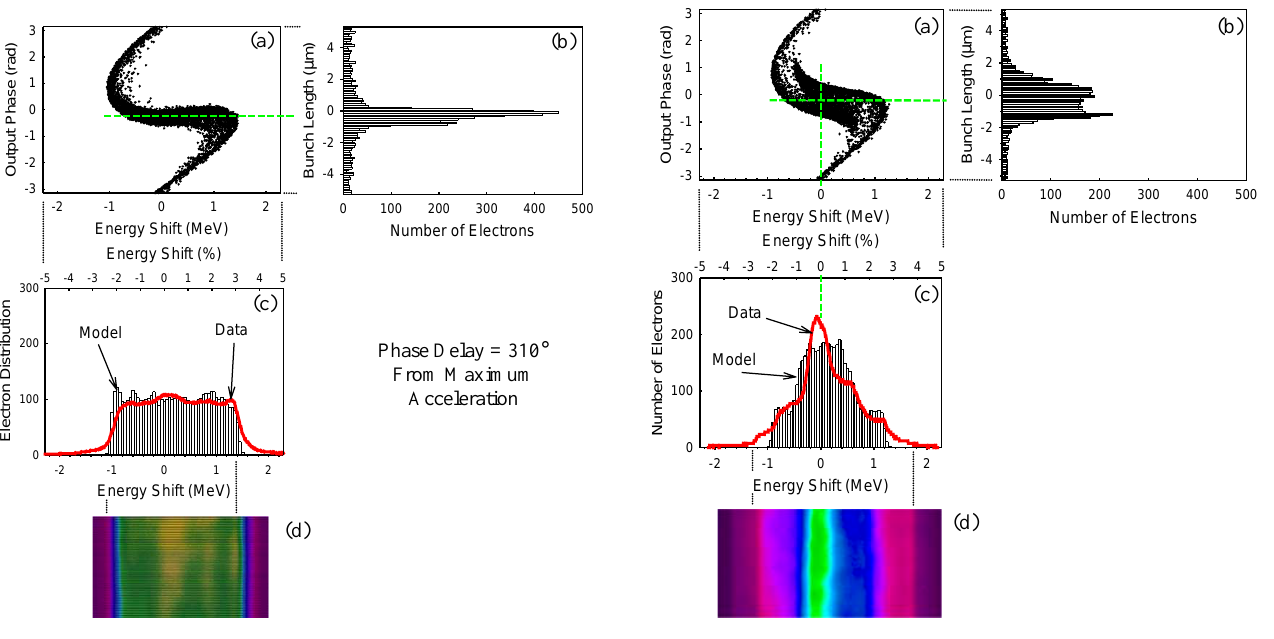
FIG. 7. (Color) Example of overmodulation in the buncher. (a) Model-predicted electron output phase versus electron en- ergy, (b) model-predicted electron bunch length, (c) electron en- ergy spectrum, and (d) raw spectrometer output for data plotted in